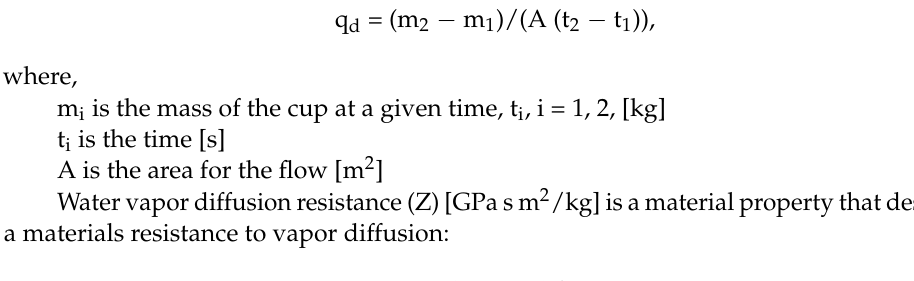
Figure 6. A cup closed with a lid consisting of membrane placed on a weight.